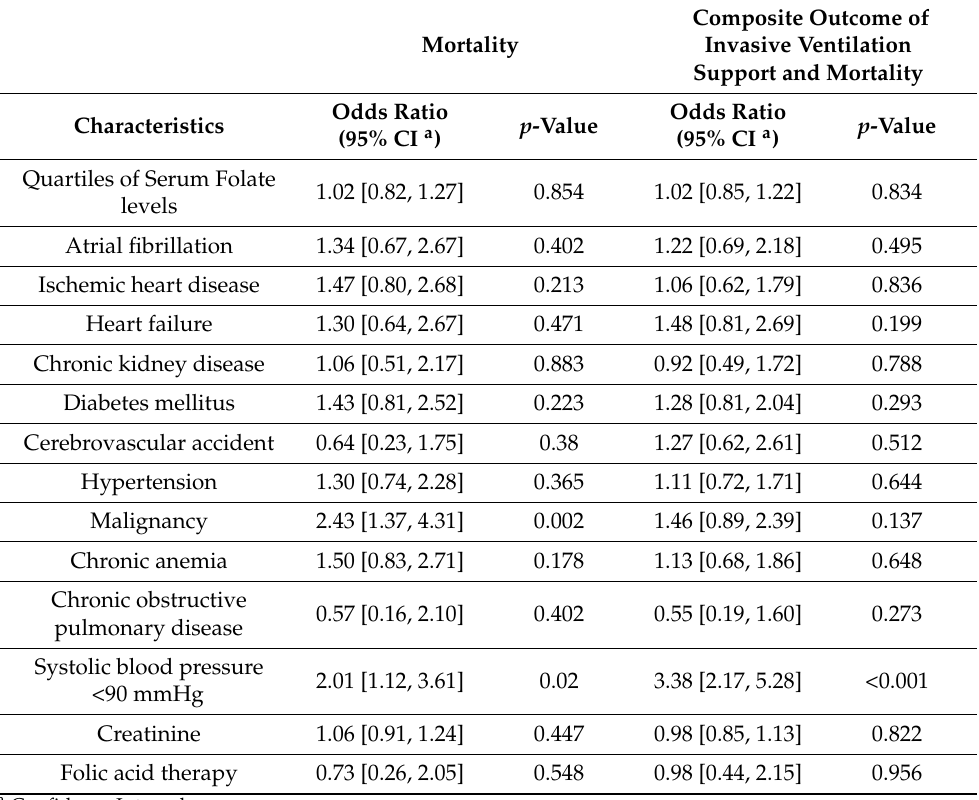
Table 7. Adjusted analysis for the association between quartiles of folate levels and mortality and a composite of invasive ventilation support and mortality in patients hospitalized with